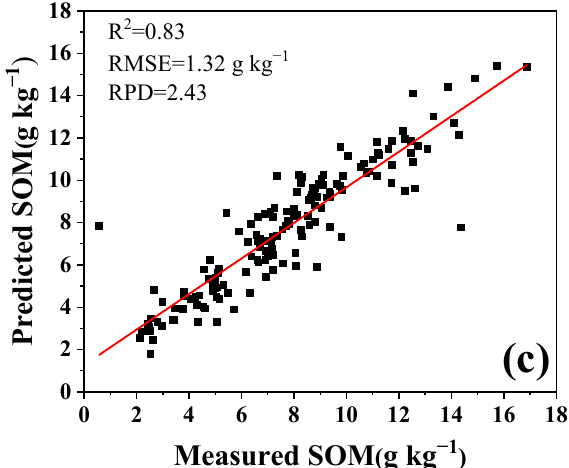
Figure 8. Scatterplot of predictions through the measured values and obtained by SAM–PLSR with calibration dataset of soils from different depths. ( a ) 0–40 cm depth; ( b ) 0–20 cm depth; ( c ) 20–40 cm depth.